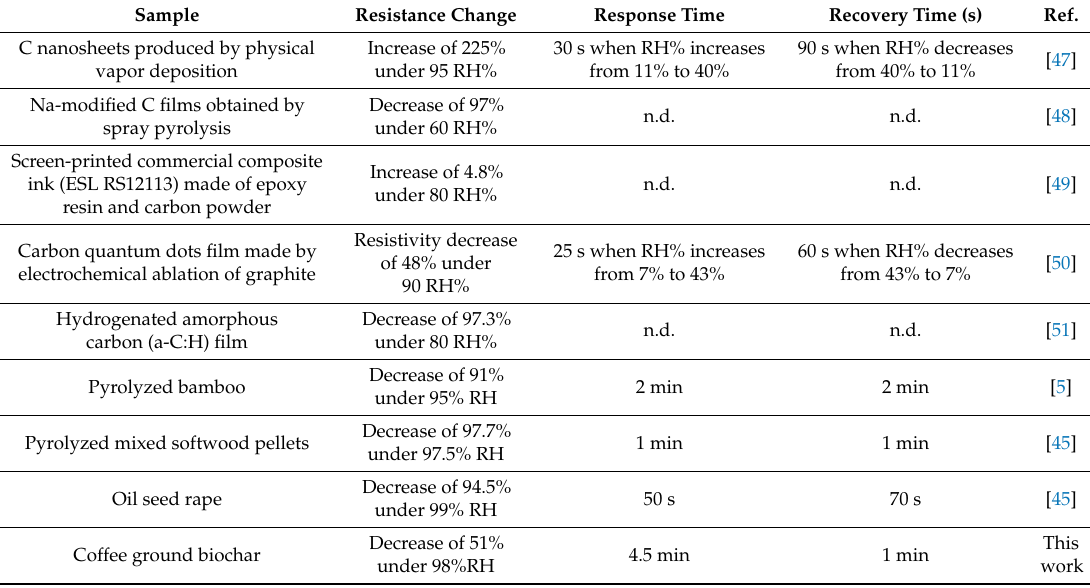
Table 2. Features of humidity sensors based on carbonaceous